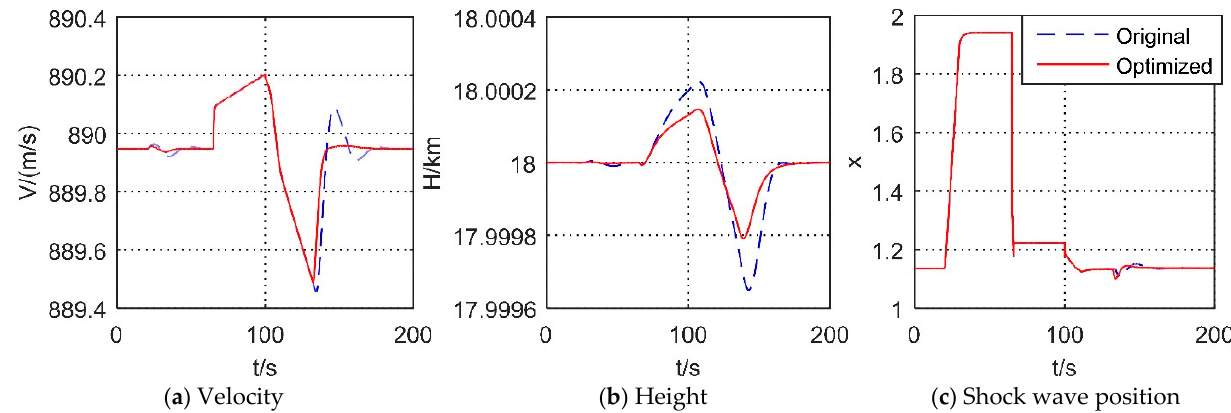
Figure 7. Comparison before and after controller’s optimization of the mode transition.